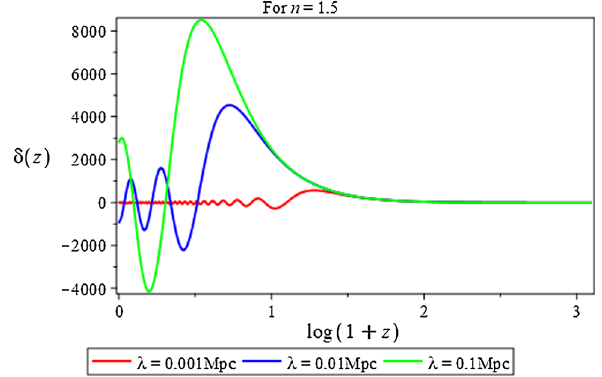
Fig. 11 δ( z ) versus z for Eq. (112) for short-wavelength mode for different λ at n = 1 .